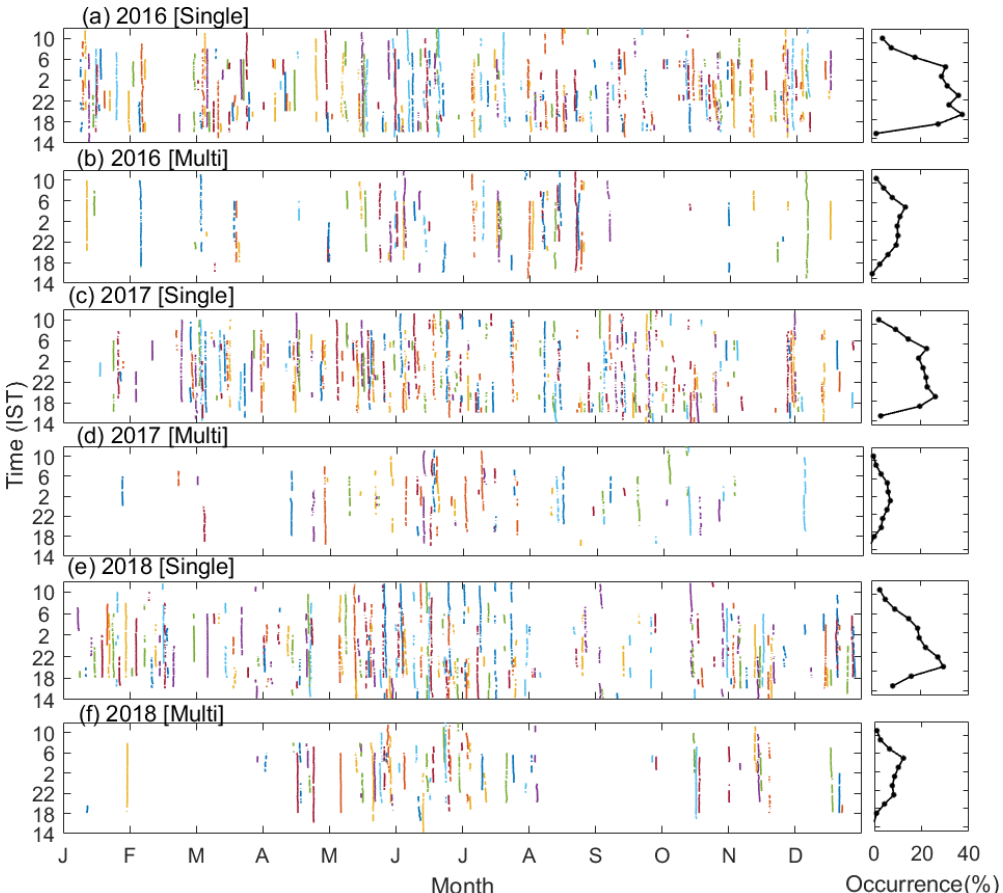
Figure 4. The day-to-day occurrence of cirrus clouds from 14:00IST on the first day to 11:00IST on the second day as well as the overall percentage occurrence for (a) single-layer and (b) multilayer cirrus clouds during 2016. Panels (c) and (d) and panels (e) and (f) are the same as panels (a) and (b) but were observed during 2017 and 2018, respectively. We use “single” to refer to the single-layer clouds and the first layer in the case of multilayer cirrus clouds; “multi” is used to refer to the second layer of cirrus clouds in the case of multilayer cirrus. Note that the colors used here have no specific meaning but are simply used to make it easier to distinguish between different